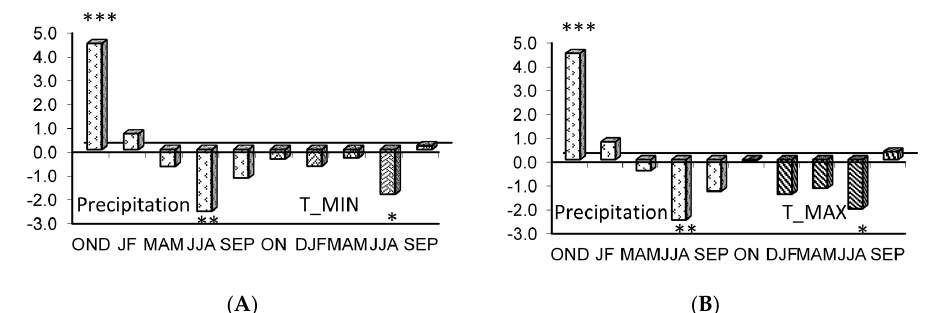
Figure 5. Response function analysis of the residual tree ring chronology of Quercus suber in the mature (MS) to monthly climatic data from October ( t − 1) to September ( t ) for the period 1937–2002 ( A ) for the joint effect (P-TMIN) of precipitation P and minimum temperature TMIN, and ( B ) for the joint effect (P-TMAX) of precipitation P and maximum temperature (TMAX). The number of stars indicates significance at 95%, 99%, and 99.99% levels, respectively. (MRC/SC = 99.99% and MRV/SV = 95%).